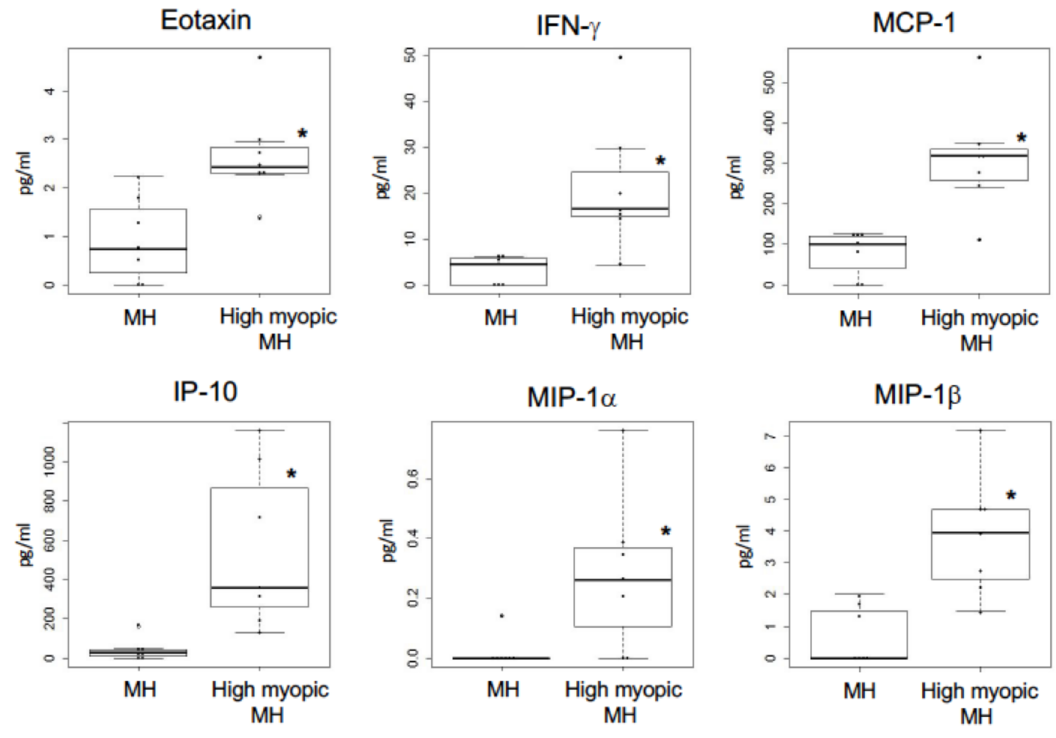
Figure 4. Comparison of inflammatory cytokines in the vitreous between MH eyes and high myopic MH eyes. Box plots of vitreous levels of up-regulated inflammatory cytokines in high myopic eyes. The lines inside the boxes denote the median. * p < 0.05, Wilcoxon rank sum test was used for comparison between 2